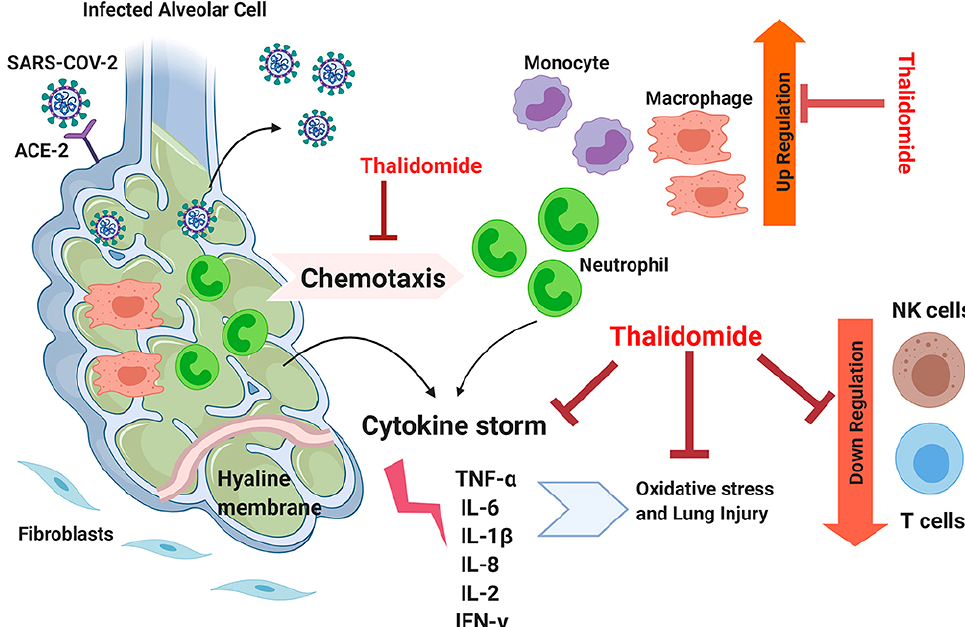
Figure 3. Schematic of the potential molecular mechanisms of the antiviral activity of thalidomide. The drug potentially blocks the chemotaxis of neutrophils and suppresses the cytokine storm as well as reduces the generation of oxidative stress. Thalidomide also stimulates natural killer (NK), and T cells activities, resulting in down-regulation of the activities of SARS-CoV-2. Reproduced from [88] with permission from Frontiers. Abbreviations: TNF- α , tumor necrosis factor-alpha; IL, interleukin; ACE-2, angiotensin-converting enzyme-2; IFN- γ , interferon-gamma.